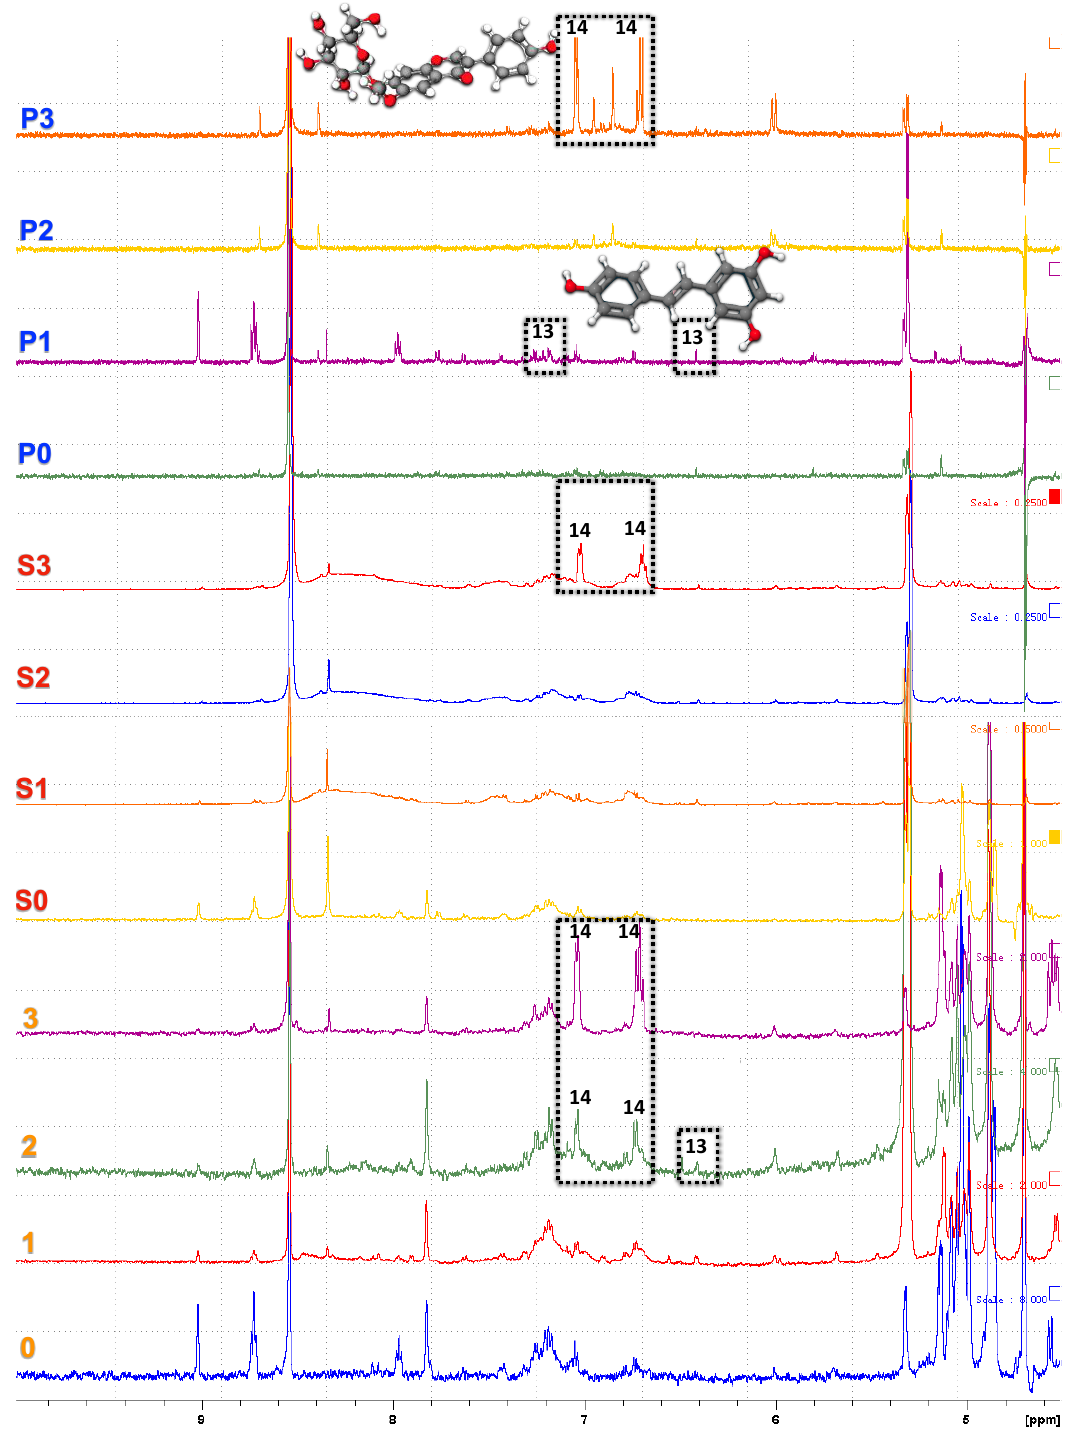
Figure 6. DPFGSE- 1 H-NMR spectra of seed soaking waters/aqueous AQ samples after different treatments. Assigned peaks arise from the presence of 13, resveratrol; 14, glycitin.